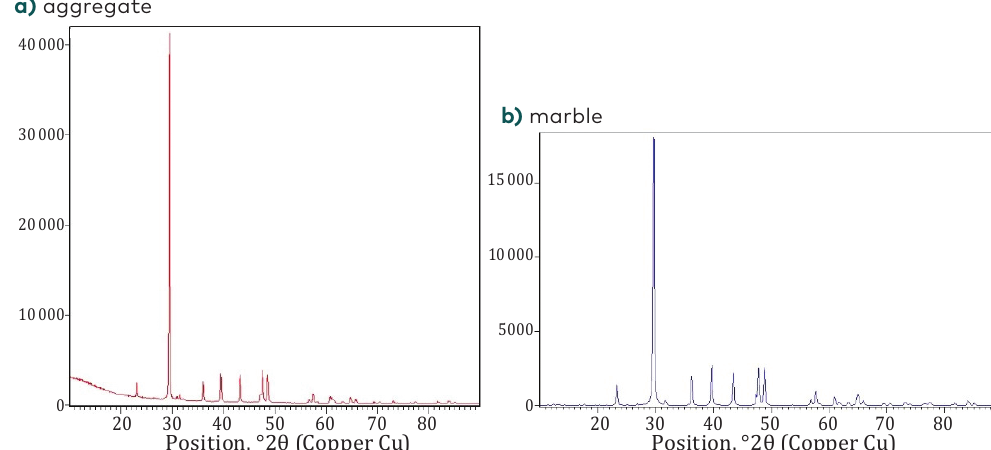
Figure 5. XRD analysis results of materials: a) aggregate; b)